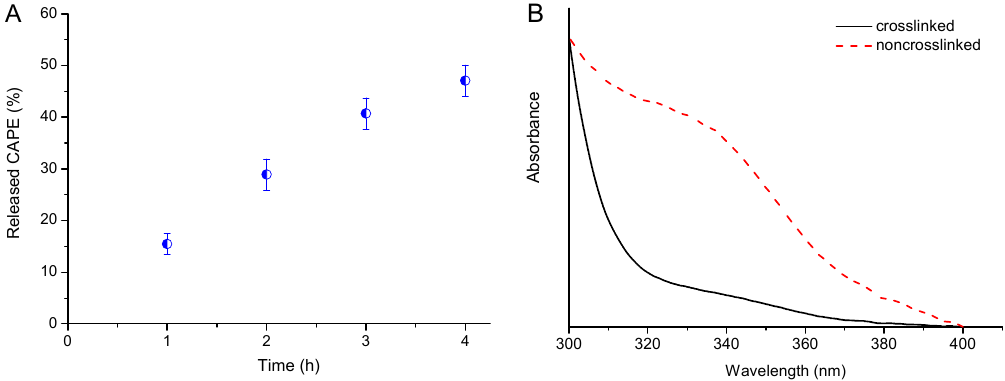
Figure 5. In vitro release of CAPE from non-crosslinked micelles ( A ), and UV-vis absorption spectra of samples taken from the external dialysis medium at the 4th hour of the release test for CAPE-loaded non-crosslinked and crosslinked micelles ( B ).